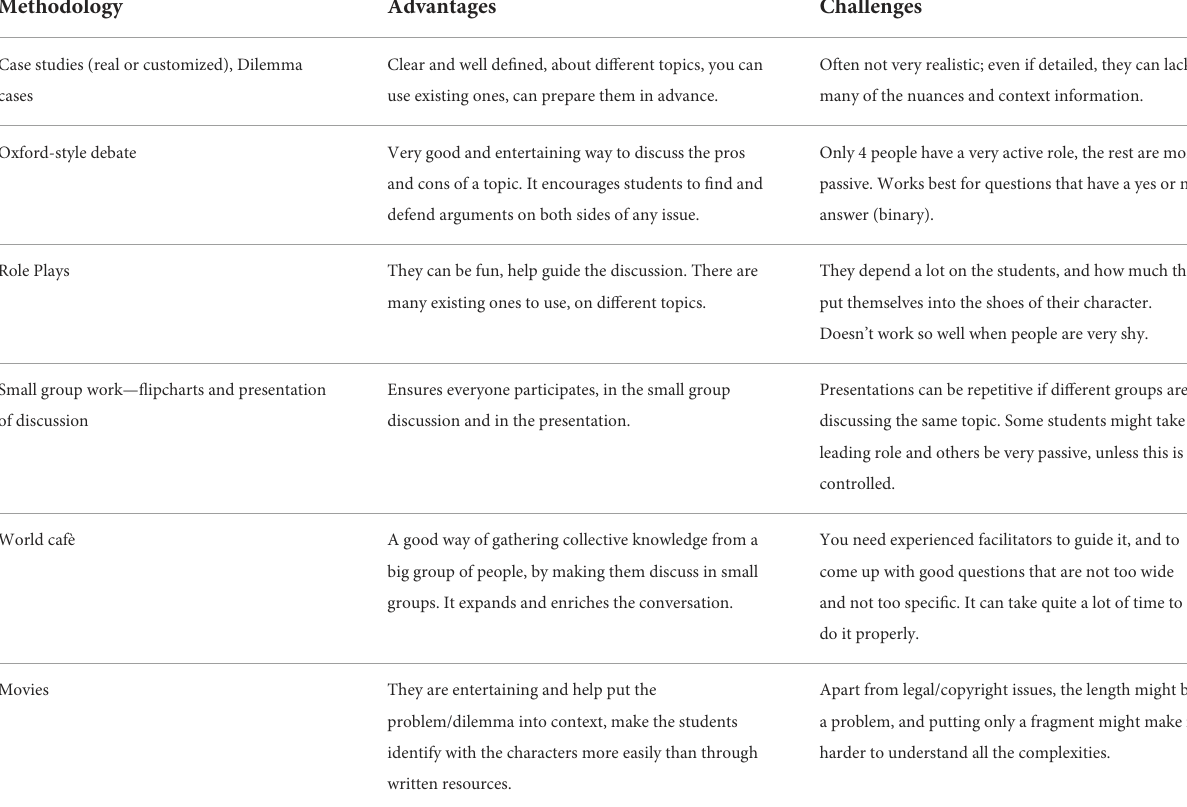
TABLE 2 Different methodologies used over the years for the “Science in action” course, and some of the advantages and challenges of each of them, in our experience.